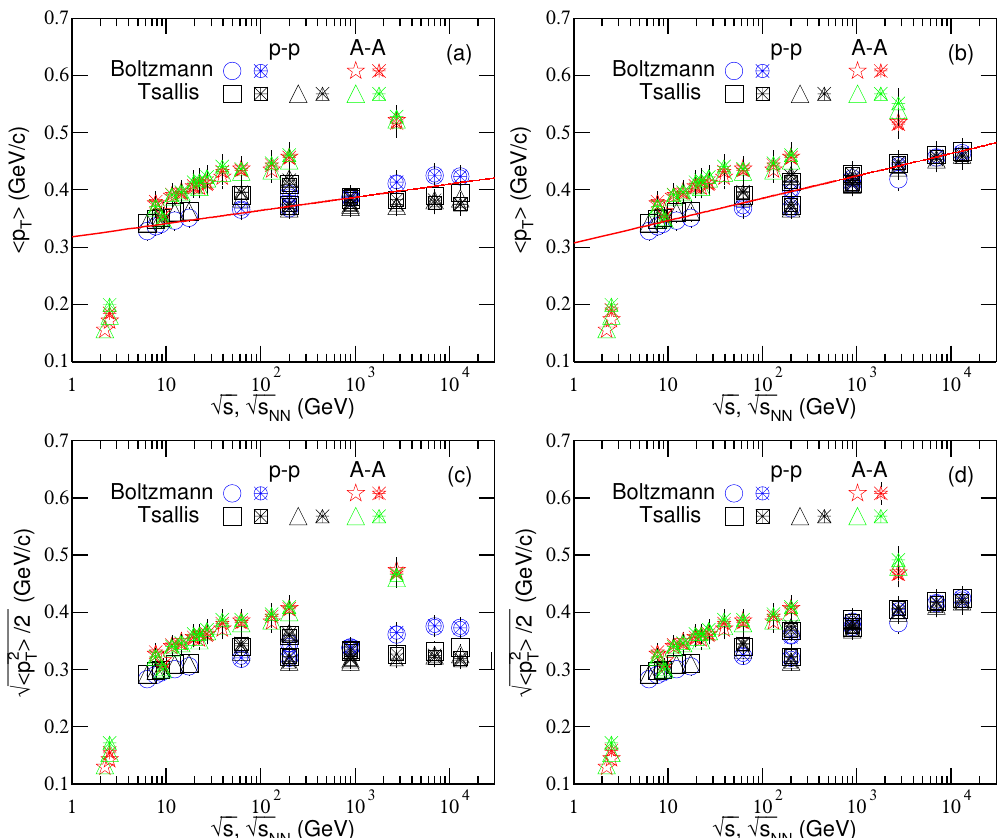
Figure 6. Same as Figure 3, but showing the results obtained from Equations (1) and (2) for the left panel, or from Equation (8) through Equations (1)–(3) for the right panel, where the excitation functions (cid:113) (cid:105) /2 are presented in panels ( a – d ) respectively. The circles represent the results (cid:104) p 2 of (cid:104) p T (cid:105) and T obtained indirectly from Equation (1) for the left panel, or from Equation (8) through Equations (1) and (3) for the right panel, by the parameter values. The squares (triangles) represent the results obtained indirectly from Equation (2) for the left panel, or from Equation (8) through Equations (2) and (3) for the right panel, by the first (second) set of parameter values. These values are indirectly obtained according to the parameter values listed in Tables 3 and 4. The red asterisks (green triangles) represent the results from AA collisions for comparisons, which are indirectly obtained according to the parameter values listed in Tables A3 and A4 in the Appendix